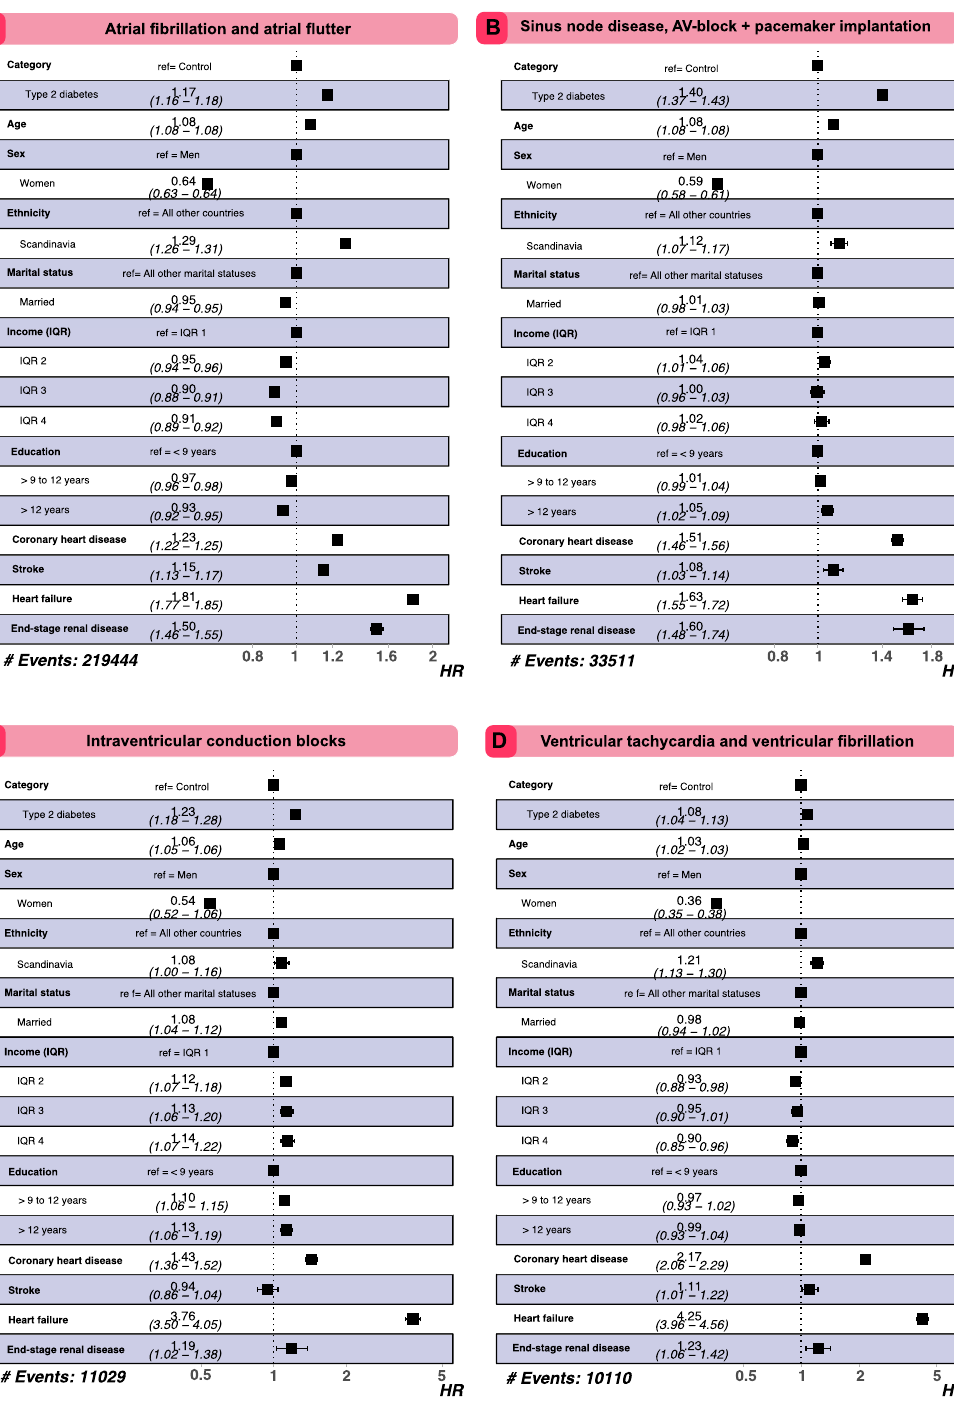
Figure 5. Excess risk for cardiac arrhythmias among patients with type 2 diabetes, as compared to matched controls. Excess risk for arrhythmias was assessed with Cox regression models for patients with diabetes and their matched controls. Inclusion of baseline comorbidities such as coronary heart disease, heart failure and stroke had no significant impact on statin-, hypertensive- and antithrombotic